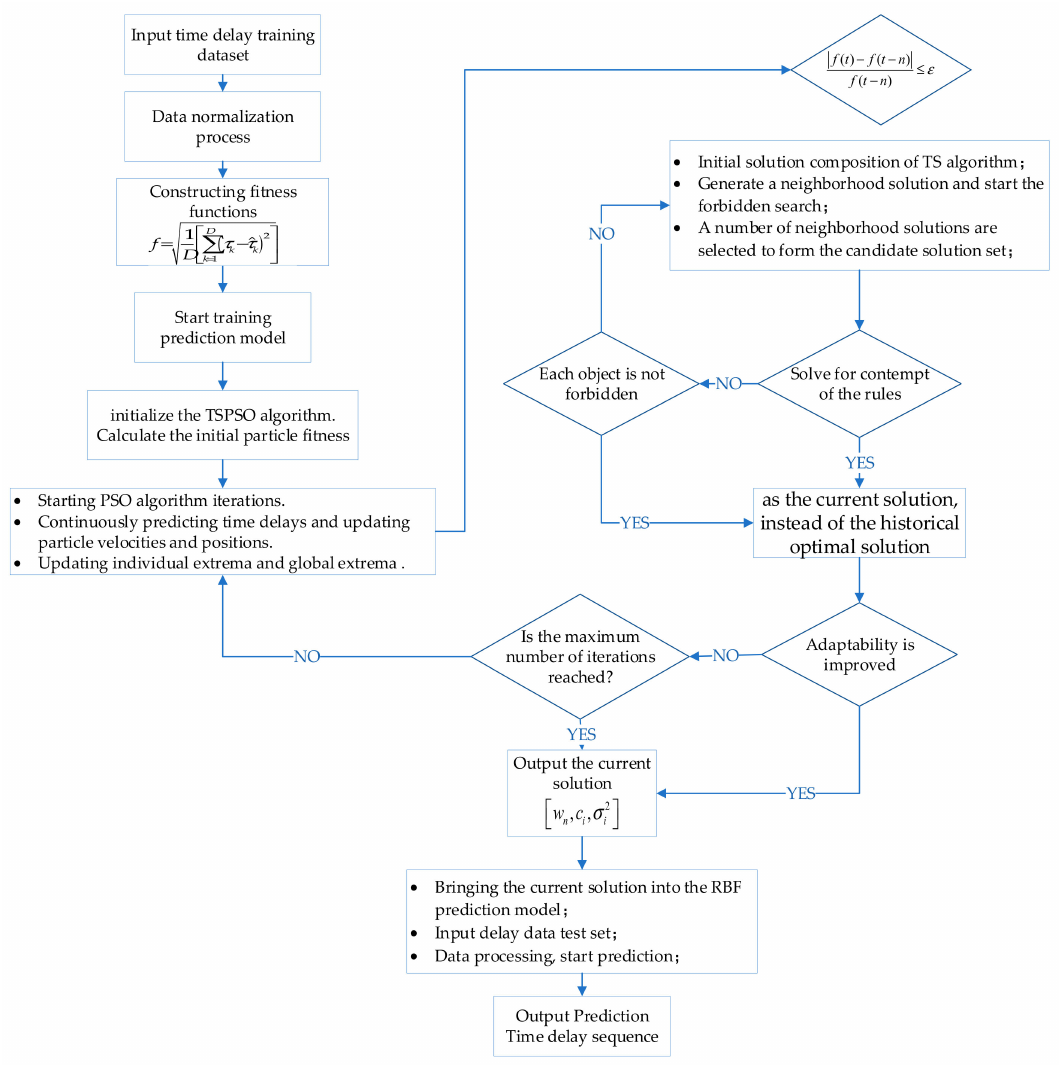
Figure 4. Delay prediction model based on improved offline PSO-RBF